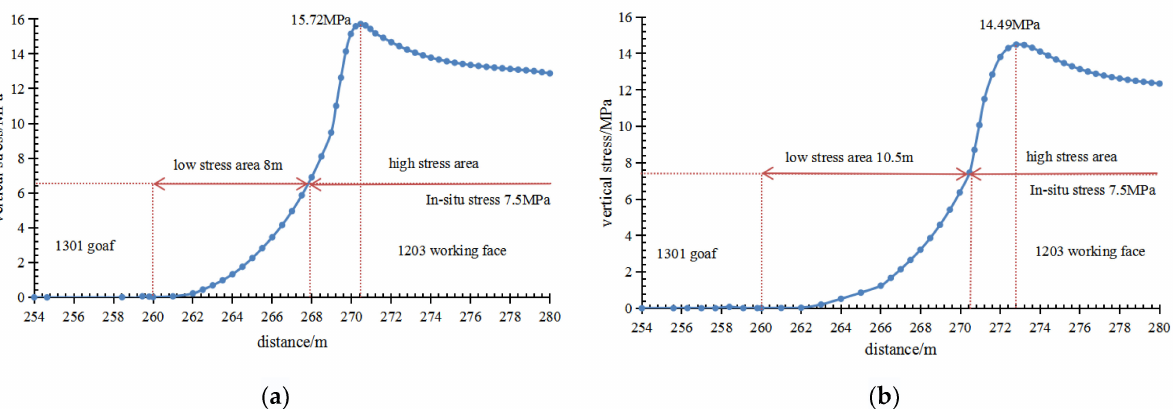
Figure 9. Diagram of the vertical stress distribution of the lateral surrounding rock of the 1301 goaf after roof cutting: ( a ) roof cutting height of 6 m (cut to the subkey strata); ( b ) roof cutting height of 12 m (cut to the main key